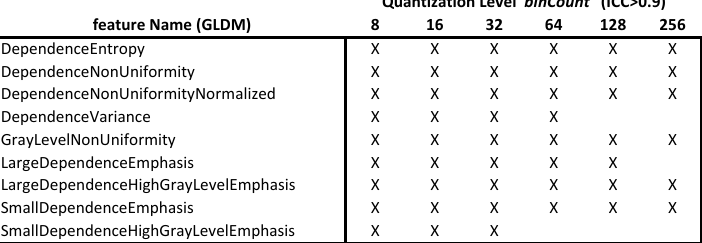
Figure 5. Dependence of the quantization level of GLDM radiomic features, considering different values (i.e., 8, 16, 32, 64, 128, and 256) of the ‘binCount’ PyRadiomics parameter. The features GrayLevelVariance , HighGrayLevelEmphasis , LargeDependenceLowGrayLevelEmphasis , LowGrayLevelEm- phasis , and SmallDependenceLowGrayLevelEmphasis were discarded, as the ICC did not overcome the cutoff for any ‘binCount’ setting.